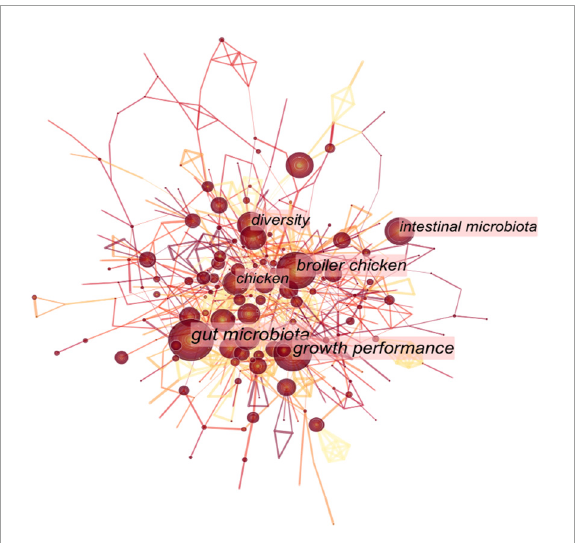
FIGURE3 The keyword analysis in the topic of avian gut microbiota published manuscripts from 2006 to